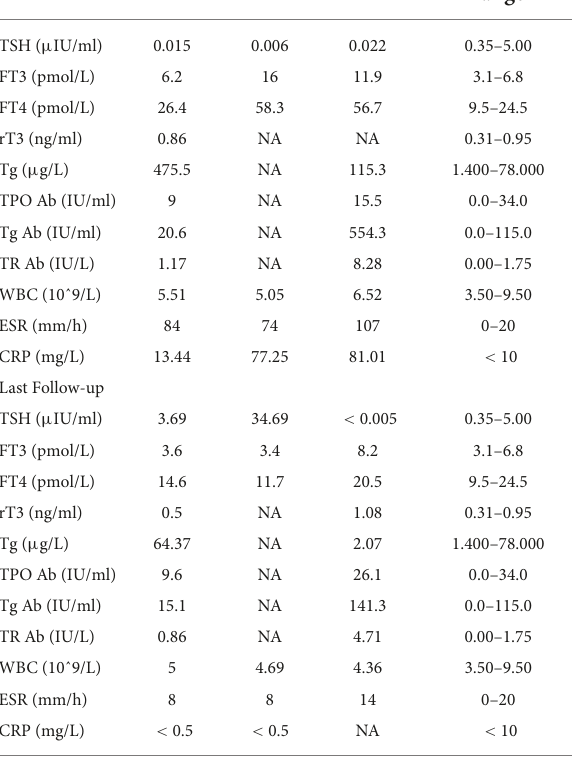
TABLE 2 Laboratory tests of three cases at follow-up 1 and last follow-up. Follow-up 1 Patient 1 Patient 2 Patient